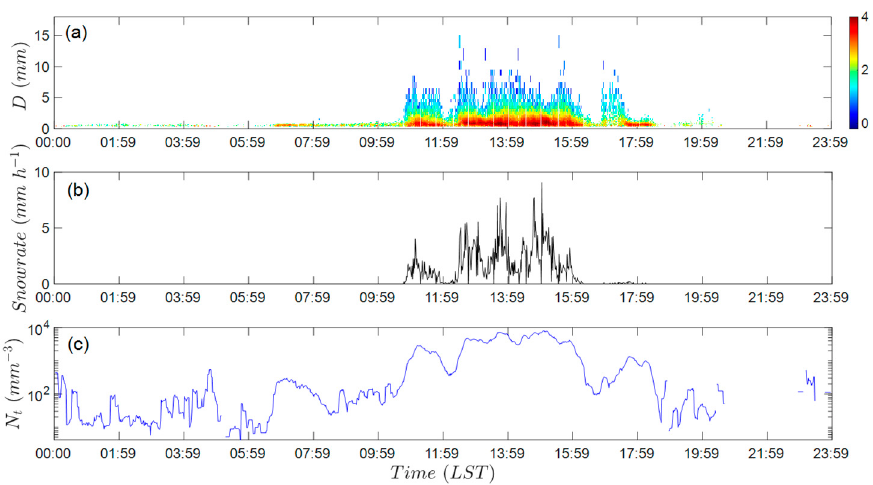
Figure 4. Distribution of ( a ) PSD N ( D ) , ( b ) Snow rate SR and ( c ) Total number concentration N t over time during the snowfall on 18 March 2022.